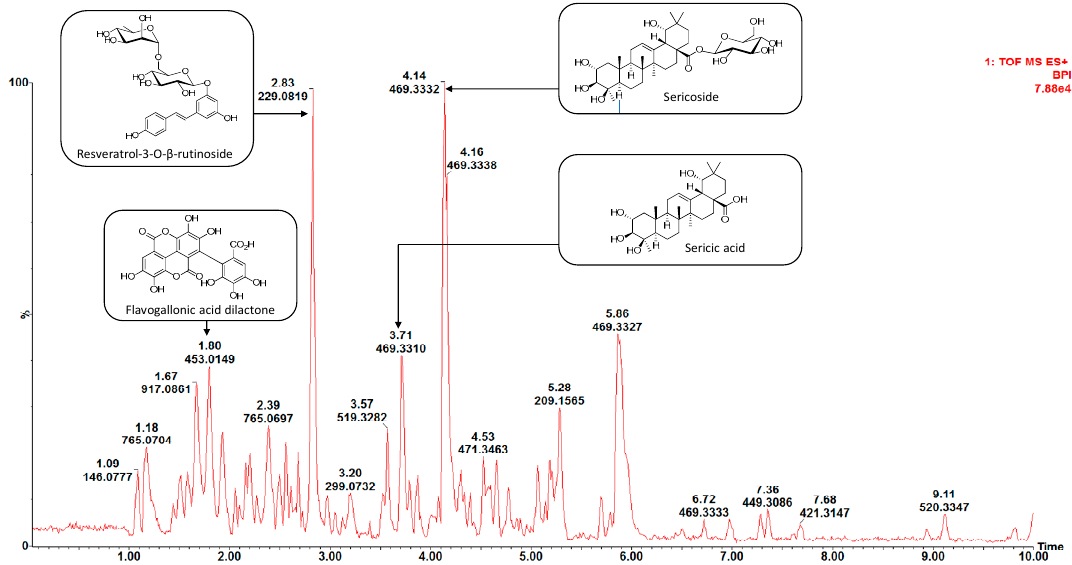
Figure 5. UPLC-MS chromatogram of dichloromethane:methanol crude extract of T. sericea root bark indicating bioactive compounds and chemical markers.